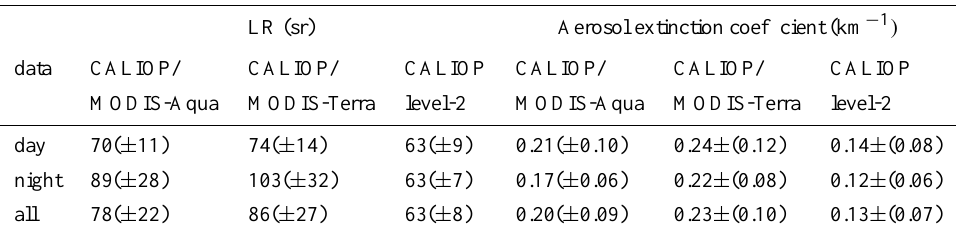
Table 2. Mean value and variability on aerosol LR and extinction coefficient in the PBL retrieved from CALIOP/MODIS-Aqua and Terra synergies and from CALIOP level-2 products.